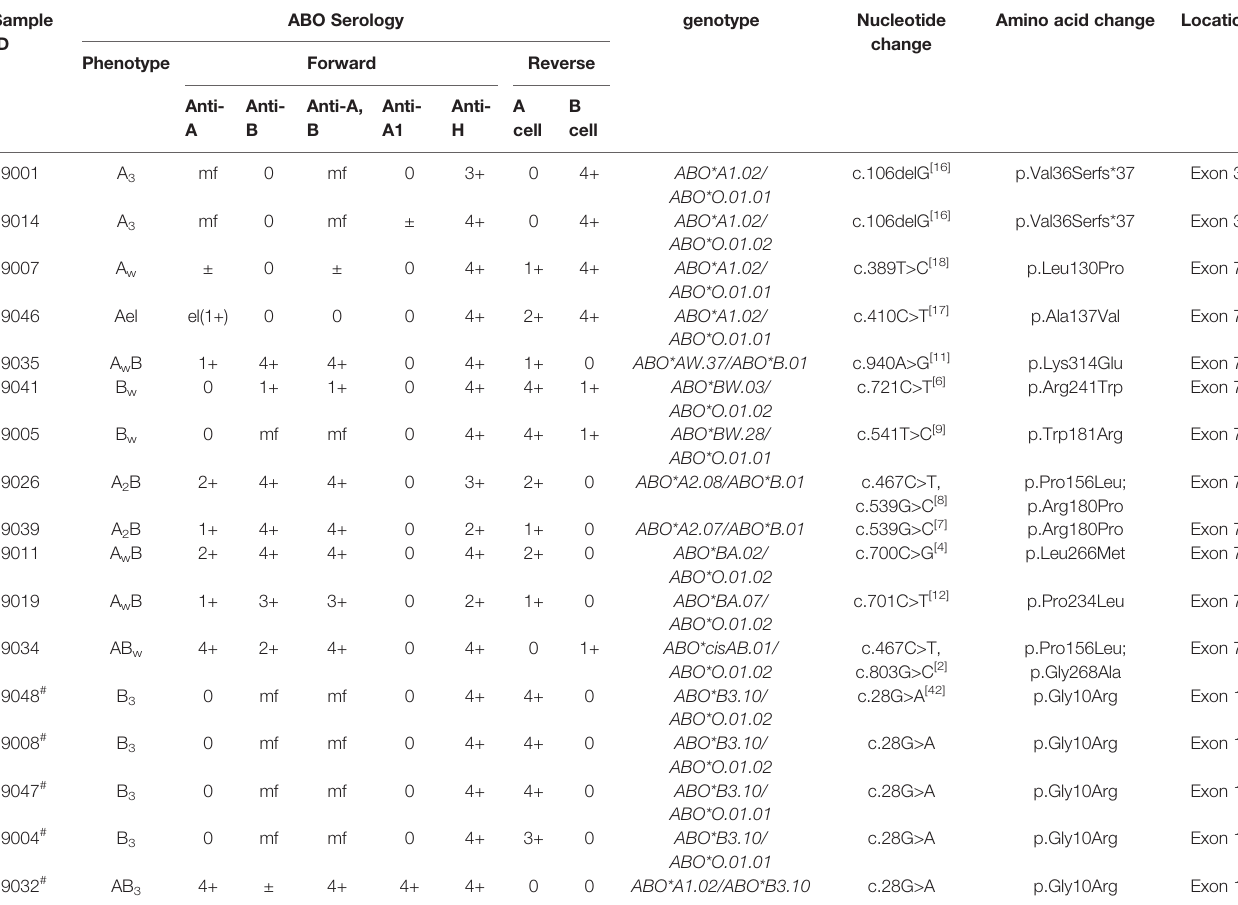
TABLE 4 | The results of the 17 ABO subtypes with variations in the coding region by Sanger sequencing and NGS method. Sample ID